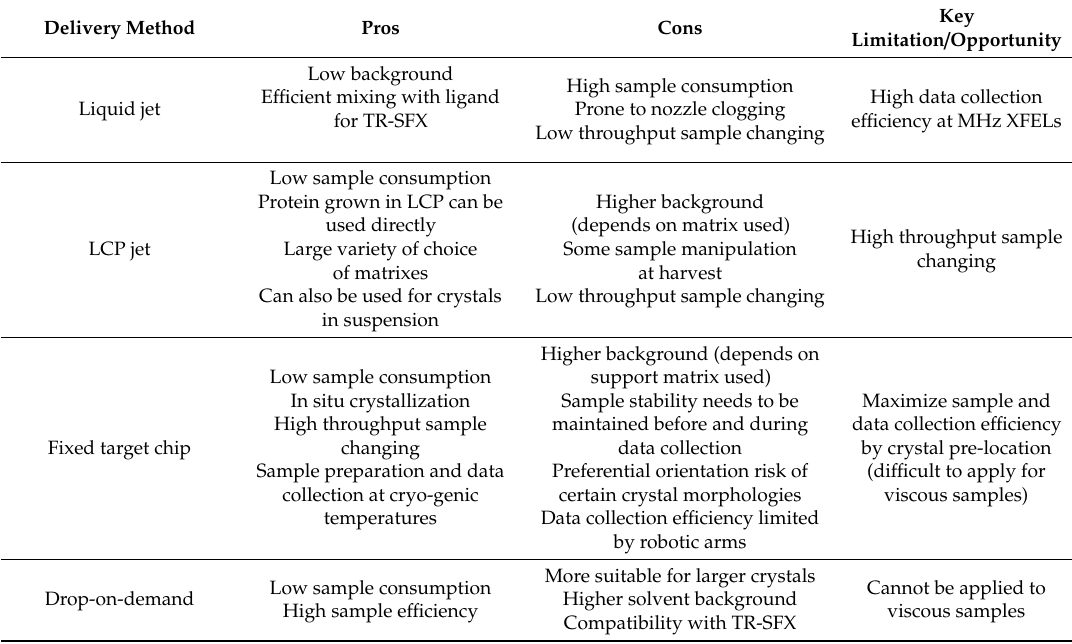
Table 1. Comparison of main sample delivery methods pros and